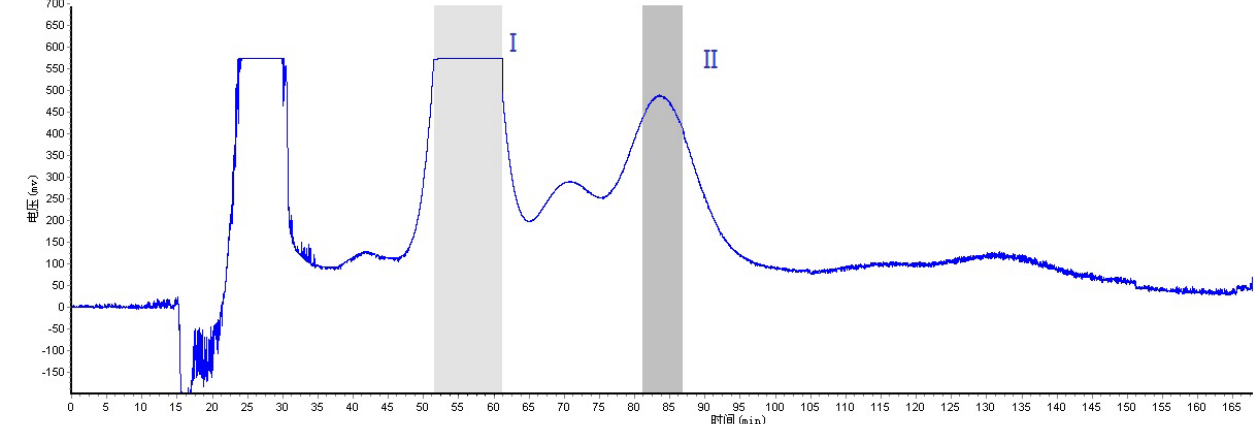
Figure 3. HSCCC chromatogram of the crude extract from the whole plant of Isodon rubescens. Two-phase-solvent system: n -hexane-ethyl acetate-methanol-water (2.8:5:2.8:5, v/v/v/v); mobile phase: the lower phase; flow-rate: 2 mL/min; revolution speed: 850 rpm; detection wavelength: 254 nm; sample size: 100 mg of crude sample dissolved in 5 mL of the lower phase; separation temperature: 25 °C; retention of the stationary phase: 61%. I, II: collected